Question: Write a single sentence explaining what this figure depicts.
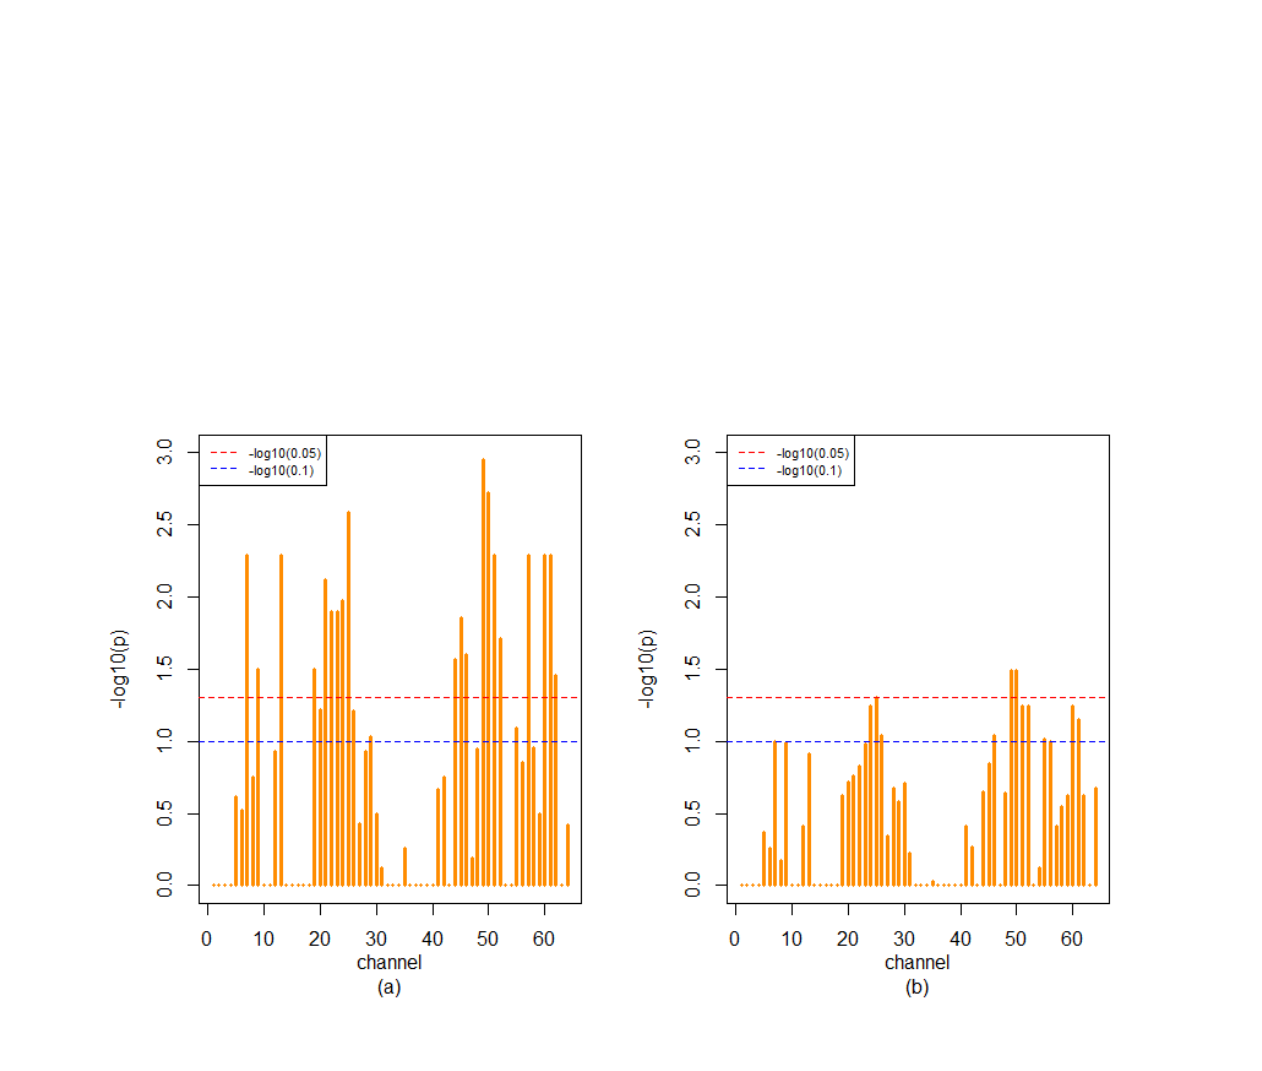
Answer: Benjamini–Yekutieli adjusted p-values (on a scale of −log10) for 64 brain channels